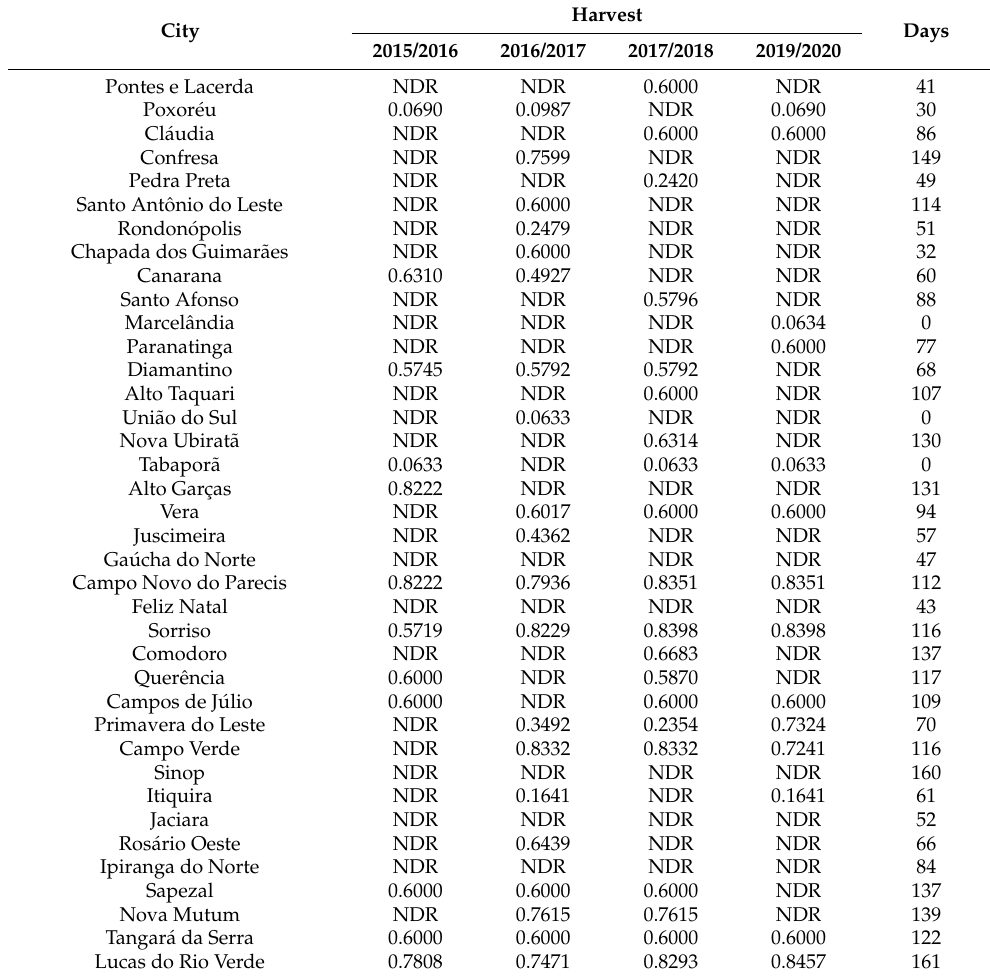
Table 6. Records of fuzzy occurrence for all localities where there was at least one record of the disease over the five harvests and number of days that the locality was susceptible to the disease.